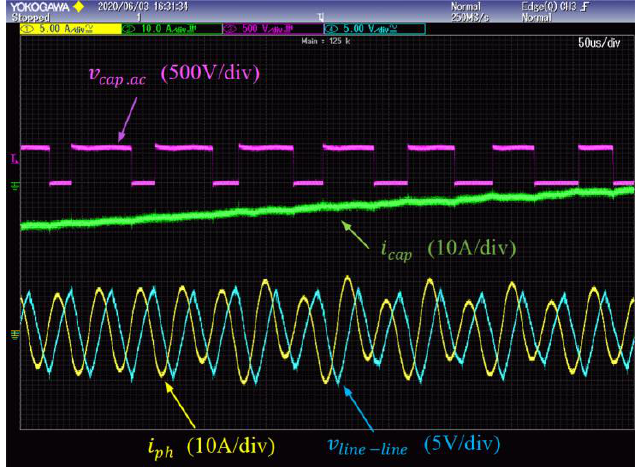
Figure 5. Experimental waveform of the motor current (motor speed = 1000 rpm and motor current = 10 A).